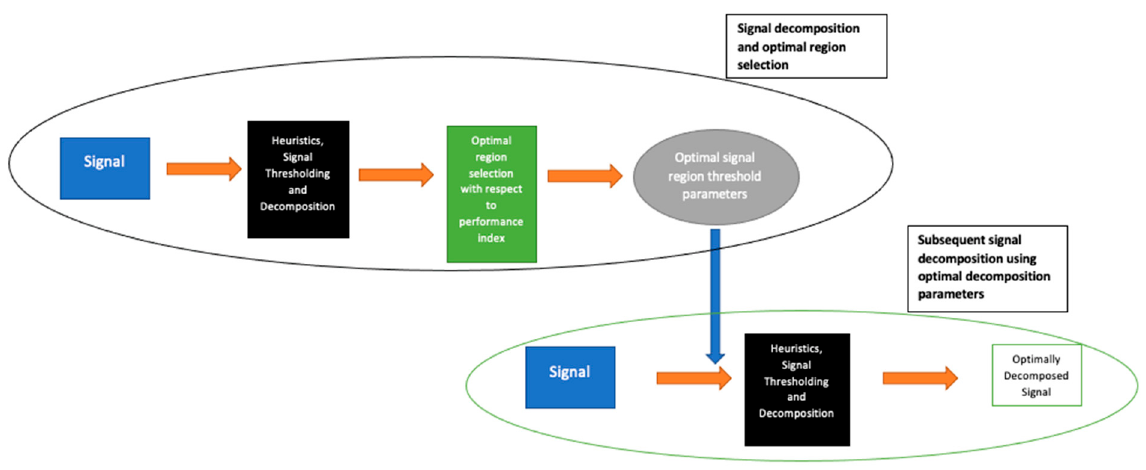
Figure 2. Flow diagram showing the various stages associated with the implementation of the LSDL.